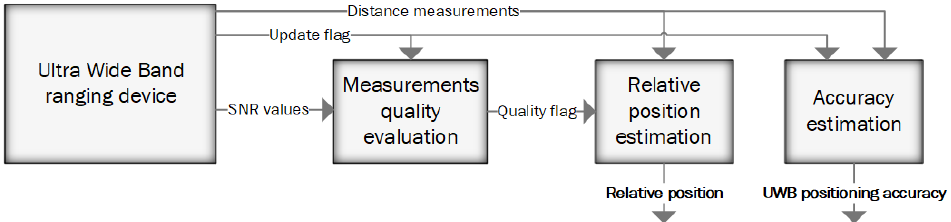
Figure 10. Diagram of the UWB positioning